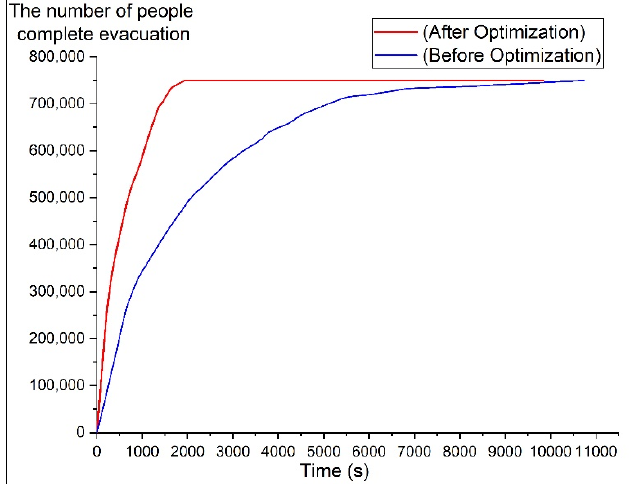
Figure 13. The comparison of the numbers of people completing evacuation before and after opti-